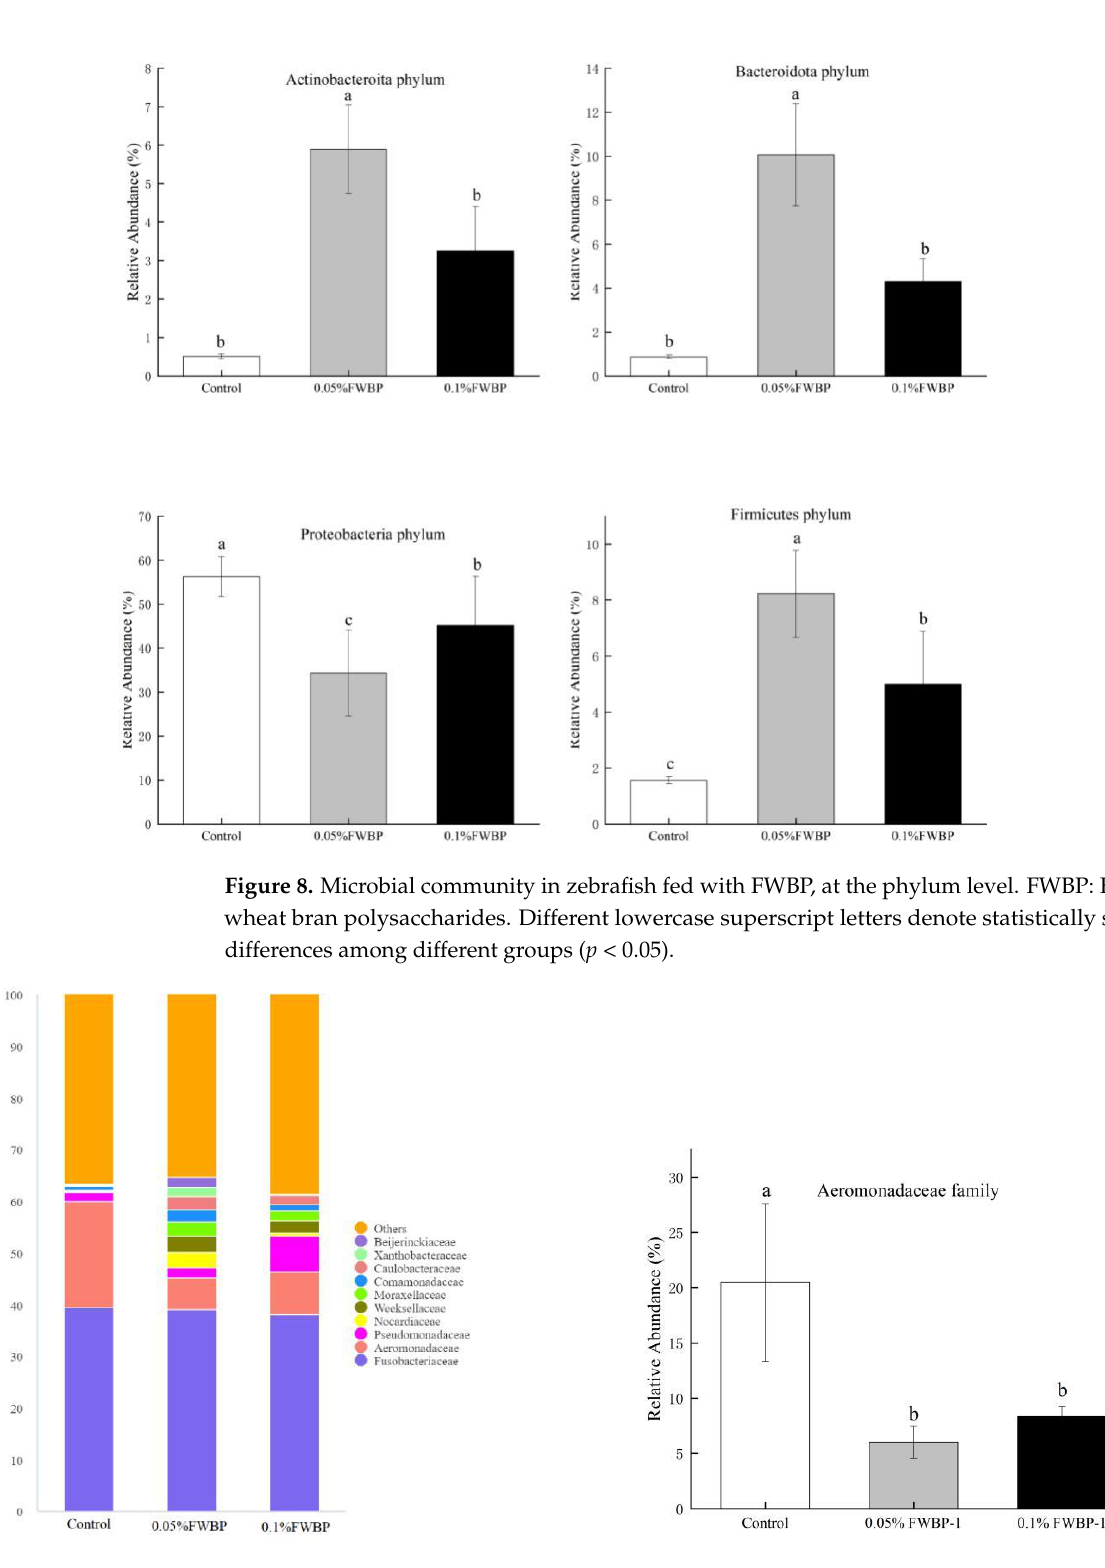
Figure 9. Microbial community in zebrafish fed with FWBP at the family level. FWBP: Fermented wheat bran polysaccharides. Different lowercase superscript letters denote statistically significant differences among different groups ( p <